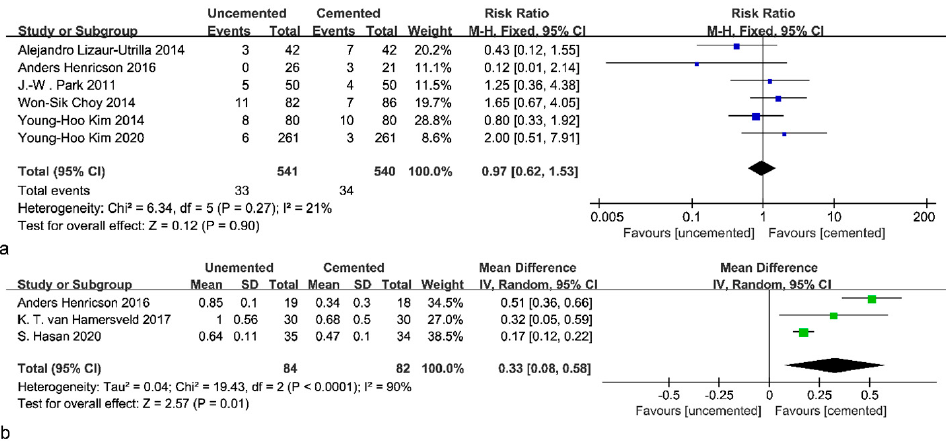
Figure 4. Forest plot of RLL and MTPM. ( a ) Forest plot of RLL [23,26–29,31]. ( b ) Forest plot of MTPM [25,26,30].